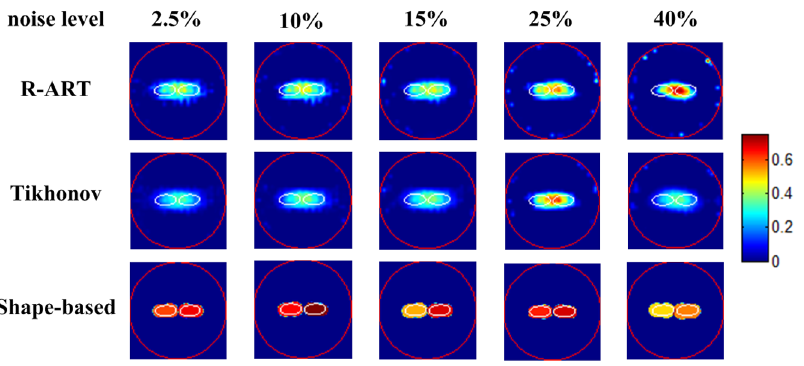
Figure 6. Reconstruction results of different noise levels. The red circle denotes the boundary of the imaged object, and the white lines denote the boundaries of the real inclusions. The slice images are of 3.0 cm